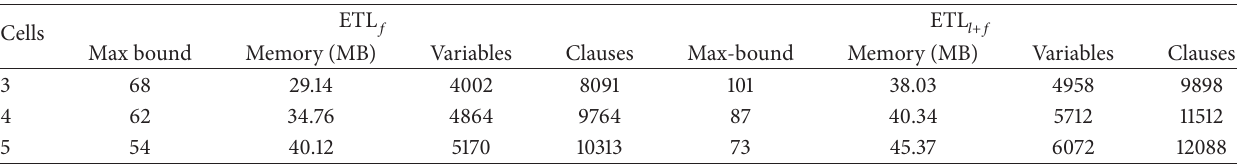
Table 3: Comparison of ETL 𝑓 and ETL 𝑙+𝑓 with safety properties.